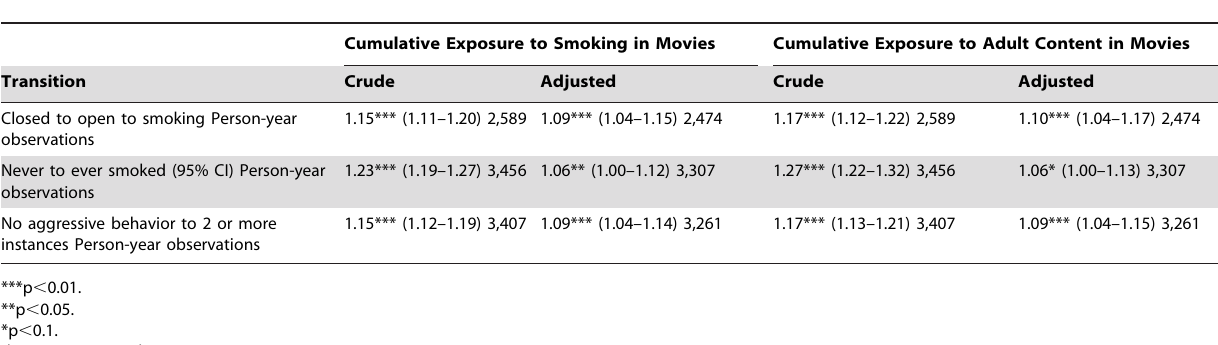
Table 3. Influence of Exposure to Smoking in the Movies and Adult Content on Initiation to Smoking, Becoming Open to Smoking, and Exhibiting Aggressive